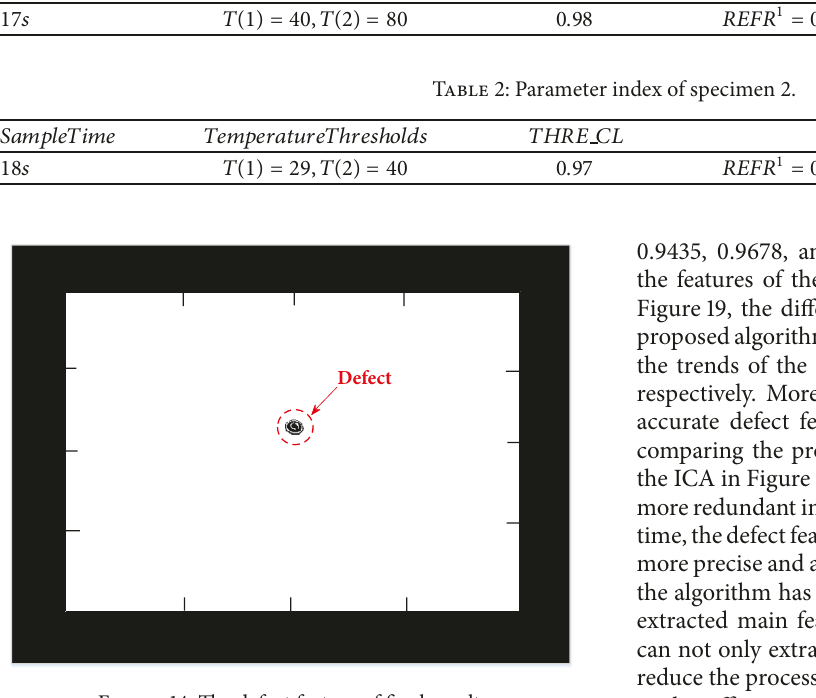
Figure 14: The defect feature of final